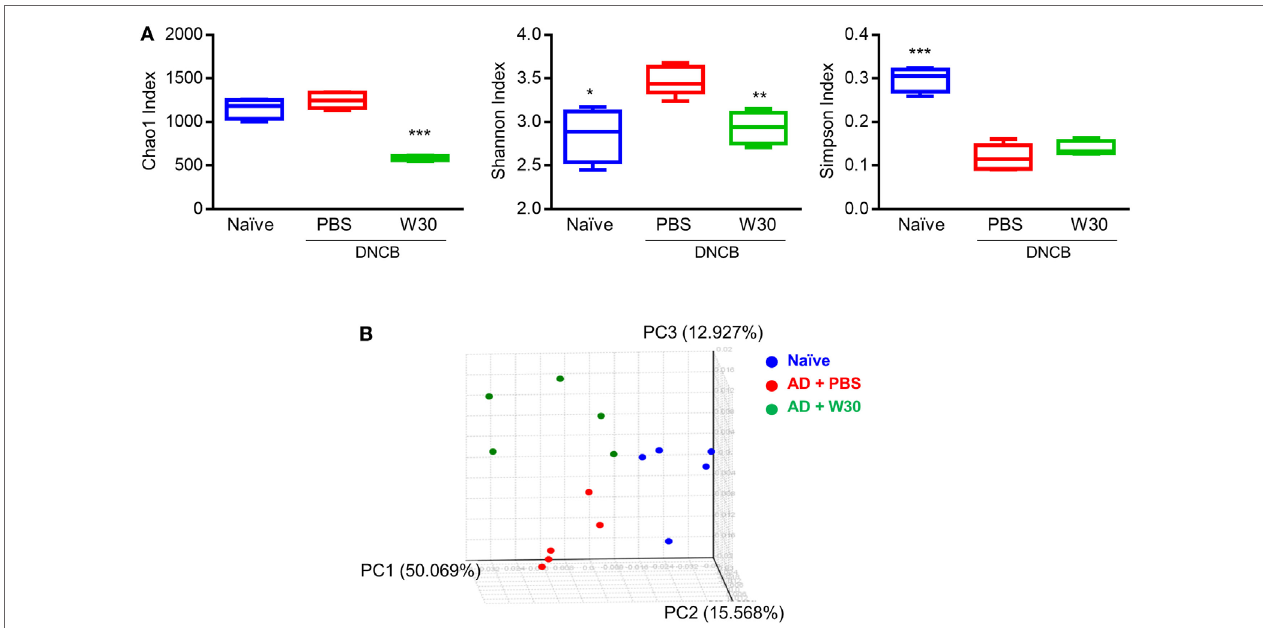
FigUre 5 | Effect of WIKIM30 on alpha and beta diversity. Alpha and beta diversity of gut microbiota in normal mice and in atopic dermatitis (AD) mice without or with WIKIM30 treatment was evaluated. (a) Richness of gut microbiota is indicated by the Chao1 index; diversity is indicated by the Shannon and Simpson indices. Student’s t -test (unpaired); * p < 0.05, ** p < 0.01, *** p < 0.001 vs. AD group. (B) Beta diversity pattern determined by principal coordinate analysis. Naïve, normal mice (blue); AD, DNCB-induced AD mice (red); W30, DNCB-induced AD mice with oral administration of WIKIM30